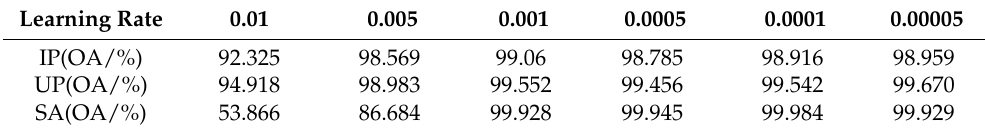
Table 5. Different learning rates.